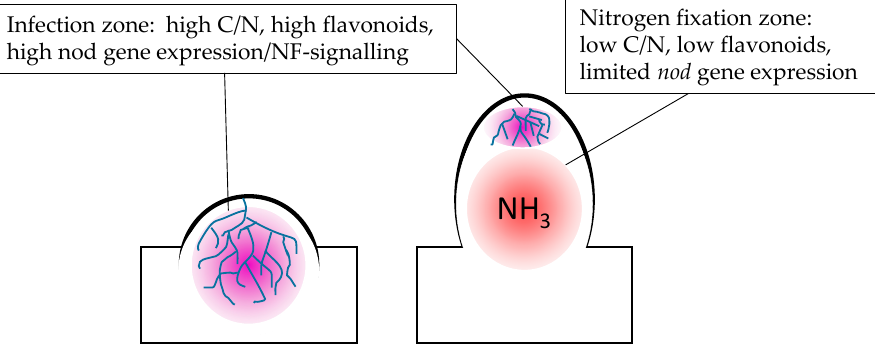
Figure 3. The association between high C/N ratios and flavonoids in nodulation. Areas undergoing infection by rhizobia are dominated by flavonoid-induced Nod factor (NF) signalling and accumulate carbon within amyloplasts. In the bacteroid-containing nitrogen fixation zone, carbon stores have been depleted, flavonoid-related gene expression is low and infection threads are mostly absent.